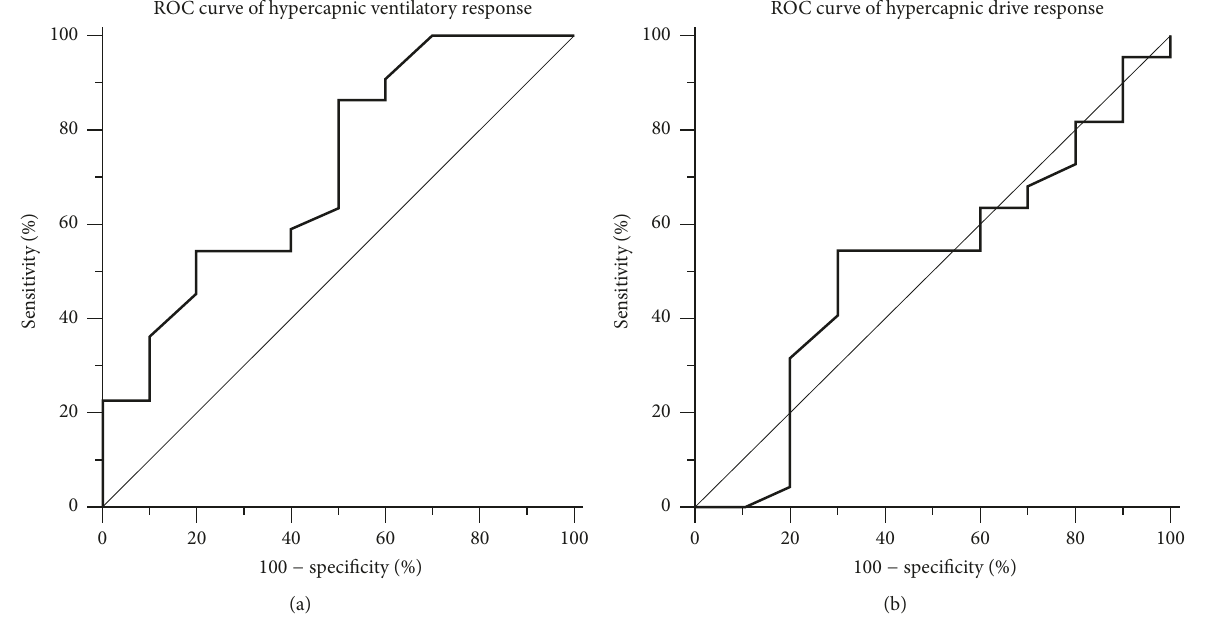
Figure 3: (a) Receiver operating characteristic (ROC) curve of hypercapnic ventilatory response and area under the curve (AUC): 0.716; (b) receiver operating characteristic (ROC) curve of hypercapnic drive response and area under the curve (AUC):